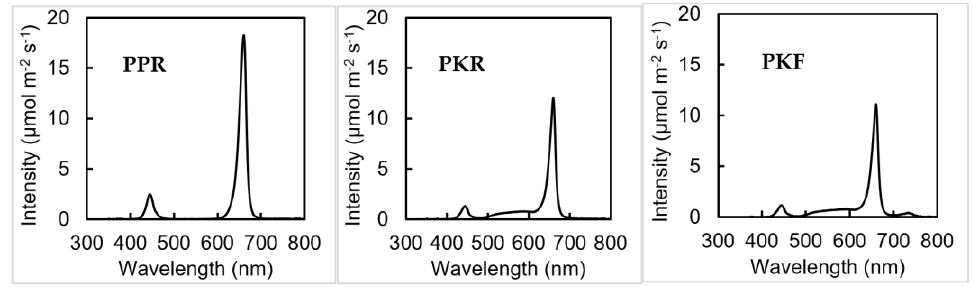
Figure 1. Spectral distribution of three LED spectra: PPR (blue 13%, red 87%), PKR (blue 8%, green, 15%, red 77%), and PKF (blue, 8%, green 15%, red 72%, FR 5%). For all light spectrum treatments, the TPFD at the top of the plants was adjusted to 250 µ mol m − 2 s − 1 by using a dimmer for PKR and PKF treatments to match the TPFD in PPR treatment, which was 250 µ mol m − 2 s − 1 with four red and blue LED tubes with a length of 1.22 m. The growing areas for all treatments were the same: 0.6 m wide and 1.22 m long. A photoperiod of 16 h d − 1 (8:00–24:00) was applied to all treatments. The TPFD and spectrum distributions were verified and measured using a Blue Wave spectroradiometer (VIS-25; StellarNet, Tampa, FL, USA). For each species, there were a total of 9 plants (pots) per